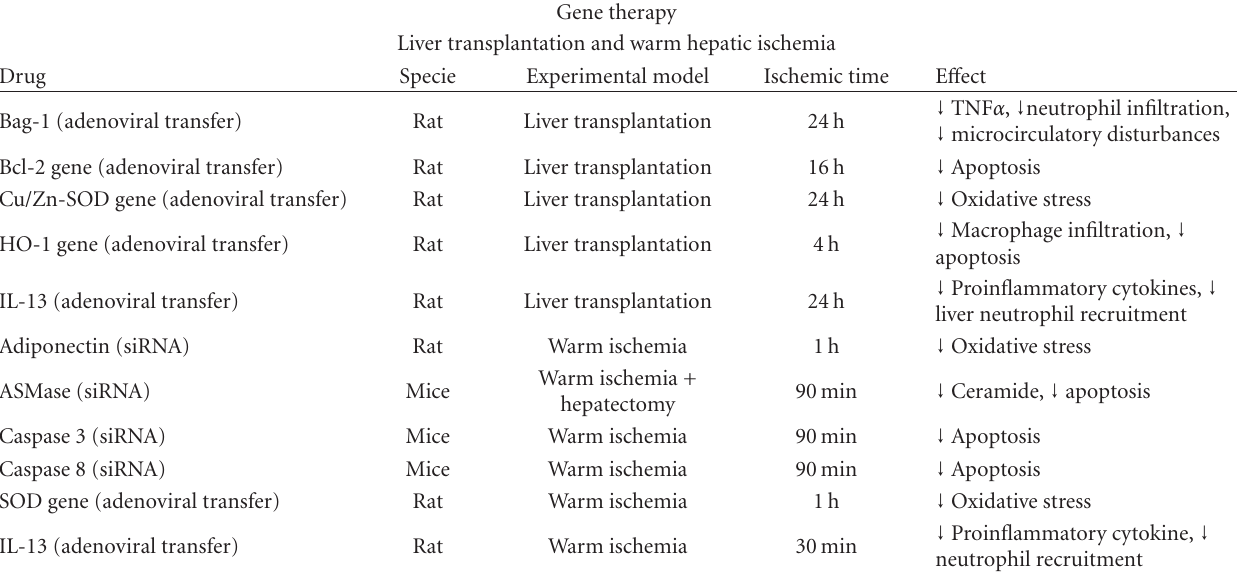
Table 3: Gene therapy to protect liver againts ischemia/reperfusion. Heme oxygenase-1, HO-1; interleukin-13, IL-13; small interference RNA, siRNA; superoxide dismutase, SOD; tumour necrosis factor TNF. Gene therapy Liver transplantation and warm hepatic ischemia Experimental